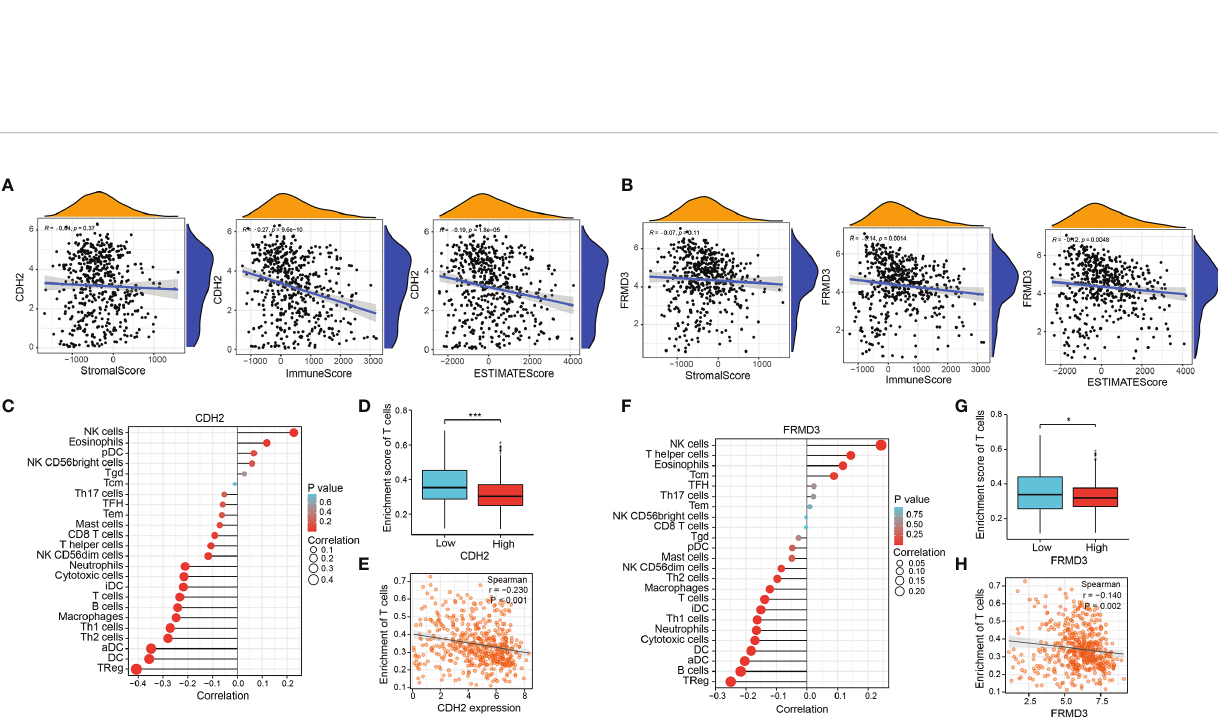
FIGURE 7 | Correlation between CDH2, FRMD3 and immune cell in fi ltration in THCA. (A, B) The correlation of stromal scores, immune scores and ESTIMATE scores and CDH2 (A) , FRMD3 (B) expression and of TCGA dataset in THCA. (C) The relationship between CDH2 expression and immune cells was calculated by ssGSEA method in TCGA dataset. (D) The correlation between different CDH2 levels and T cell enrichment in TCGA dataset. (E) The correlation between CDH2 expression and T cell enrichment by spearman correlation analysis. (F) The relationship between FRMD3 expression and immune cells was calculated by ssGSEA method in TCGA dataset. (G) The correlation between different FRMD3 levels and T cell enrichment in TCGA dataset. (H) The correlation between FRMD3 expression and T cell enrichment by spearman correlation analysis. *P < 0.05; ***P <